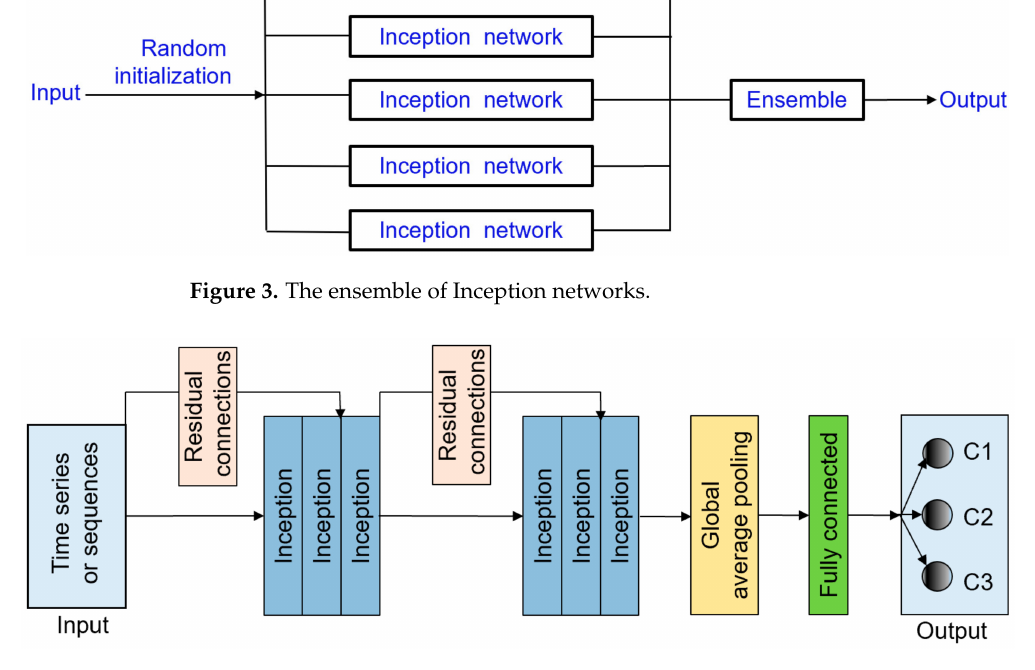
Figure 4. The adopted Inception network architecture for time series